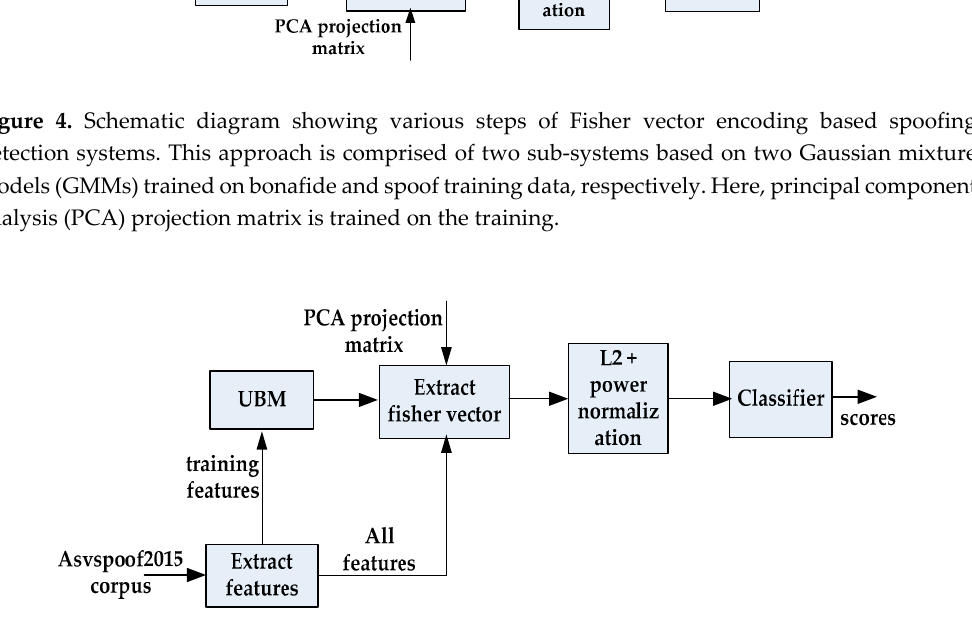
Figure 5. Schematic diagram showing various steps of Fisher vector encoding based spoofing detection systems. In this approach, a universal background model (UBM) is trained on the entire (bonafide + spoof) training data. Here, PCA projection matrix is trained on the training